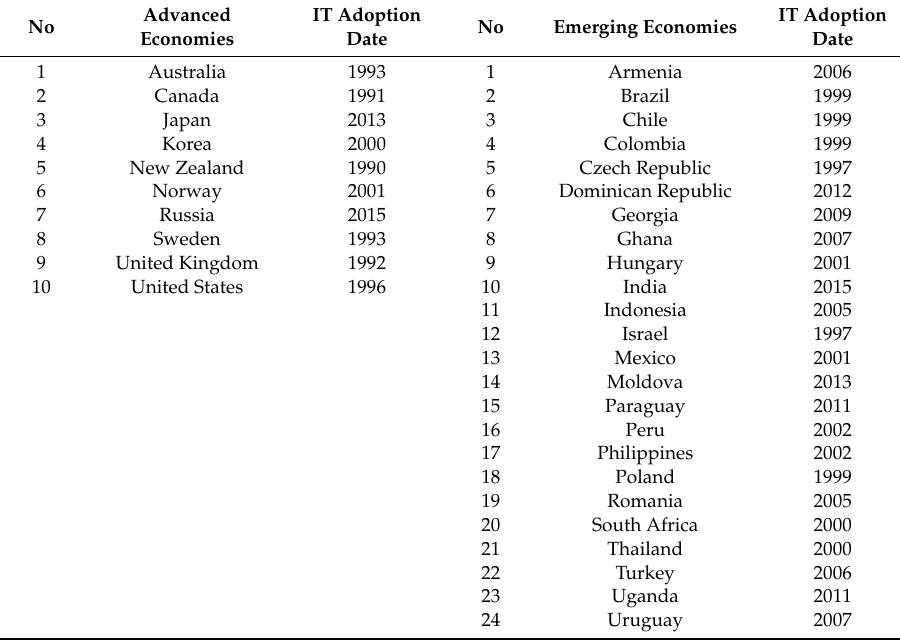
Table A1. List of Countries and IT Adoption Dates.